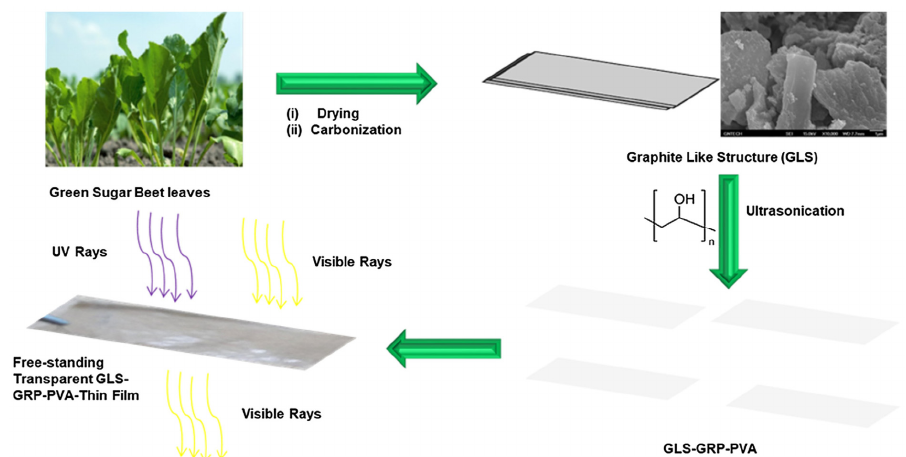
Figure 3. Schematic diagram representing the green synthesis of graphene sheets from sugar beet leaves in presence of PVA. Reproduced with permission [29]. Copyright 2021, Elsevier.